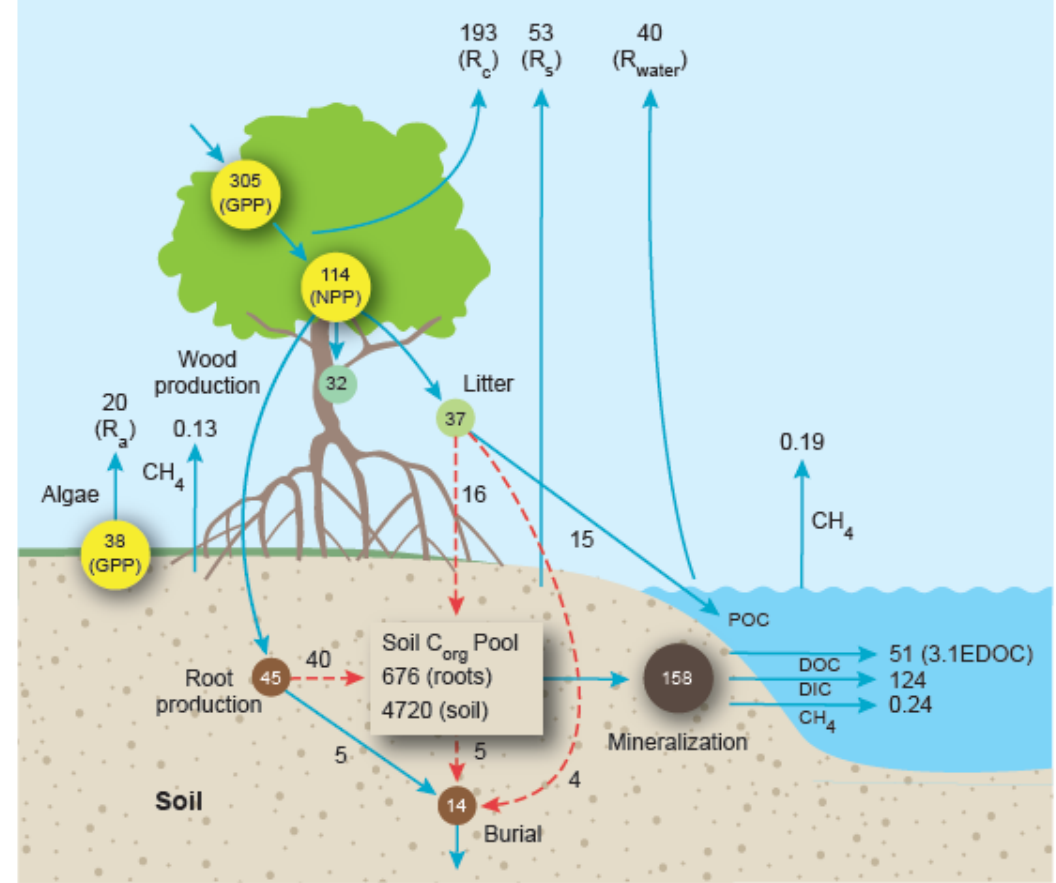
Figure 5. A mass balance model of carbon flow through the world’s mangrove ecosystems, updated from [2]. Units are Tg C a − 1 . The budget assumes a global mangrove area of 86,495 km 2 [116]. Solid blue arrows represent mean values based on empirical data (see text for explanation and references.) Dashed red arrows represent mean values estimated indirectly (by difference). The C org pool (both roots and soil) in soils to a depth of 1 m is presented as a box in the forest floor with units of Tg C. Unquantified inputs of dissolved carbon from land-derived groundwater and organic matter inputs from adjacent marine and catchments are not depicted. Abbreviations: GPP = gross primary production; NPP = net primary production; R Aa = algal respiration; R C = canopy respiration; R S = soil respiration at soil surface; R WATER = waterway respiration; POC = particulate organic matter; DIC = dissolved inorganic carbon; DOC = dissolved organic carbon; CH 4 = methane; EDOC = exchangeable dissolved organic carbon.